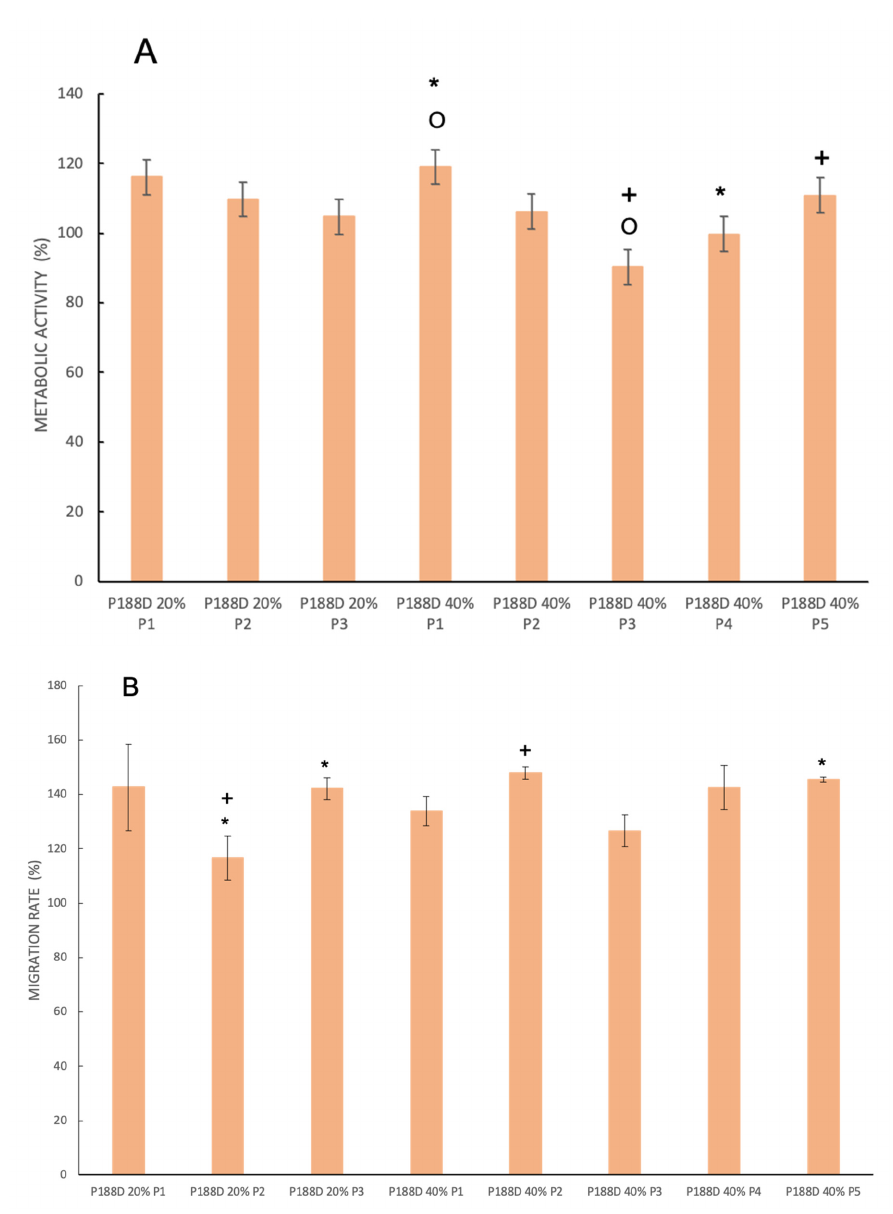
Figure 3. Keratinocyte metabolic activity ( A ) and keratinocyte migration rate ( B ) (in comparison to the control) in the presence of peptide fraction. Same symbol shows significant differences between groups ( p < 0.05). *. + statistical significant between the